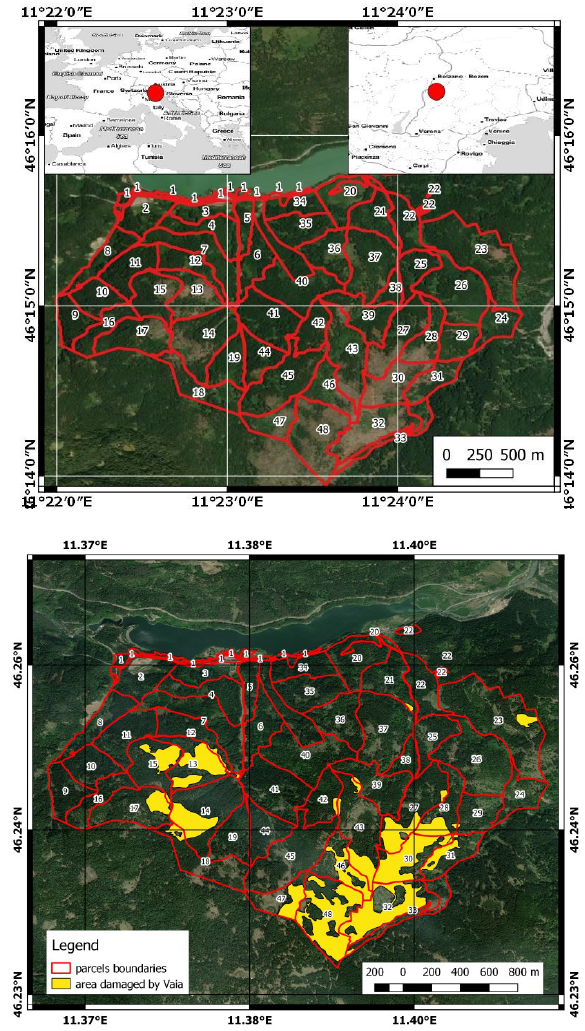
Figure 1. Location of study area (top) and area with damaged areas (bottom).